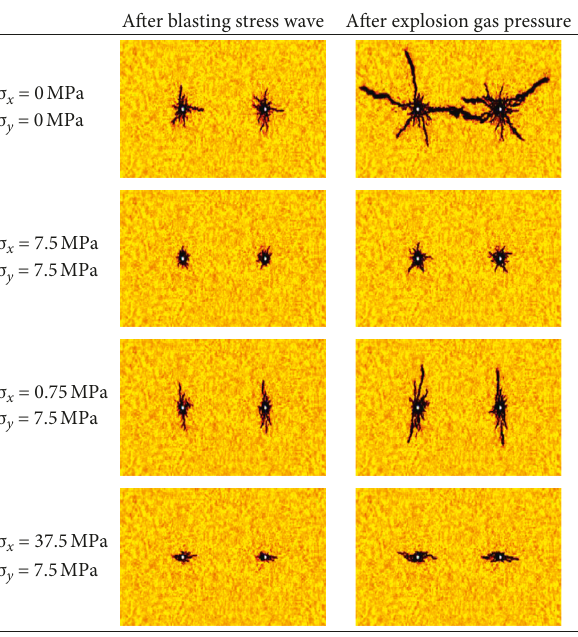
Figure 9: The development of rock-blasting damage under dif- ferent in situ stress conditions